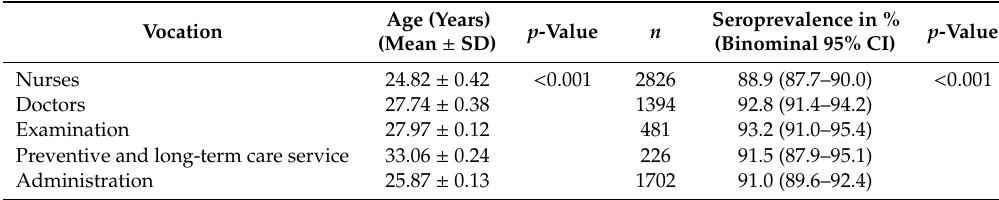
Table 2. Crude seroprevalence by vocation ( n = 7314).